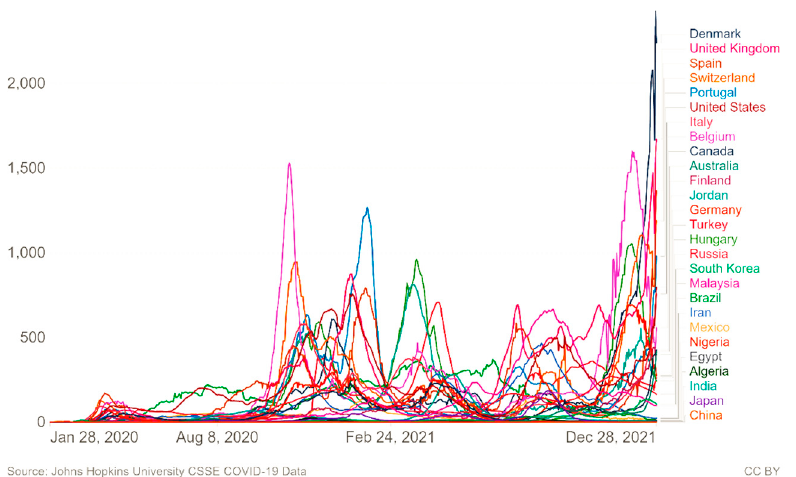
Figure 2. Daily confirmed COVID-19 cases per million people in these counties based on a 7-day rolling average.